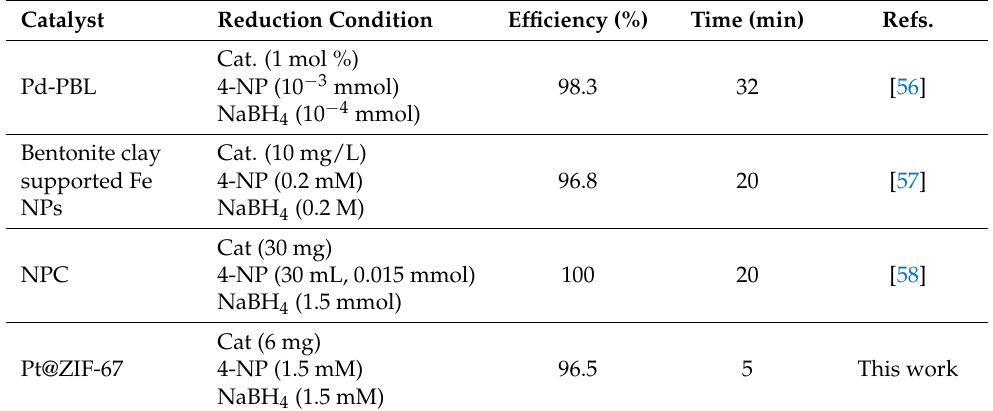
Table 5. Summary of materials that can be used for the reduction of 4-NP using NaBH 4 previously reported.